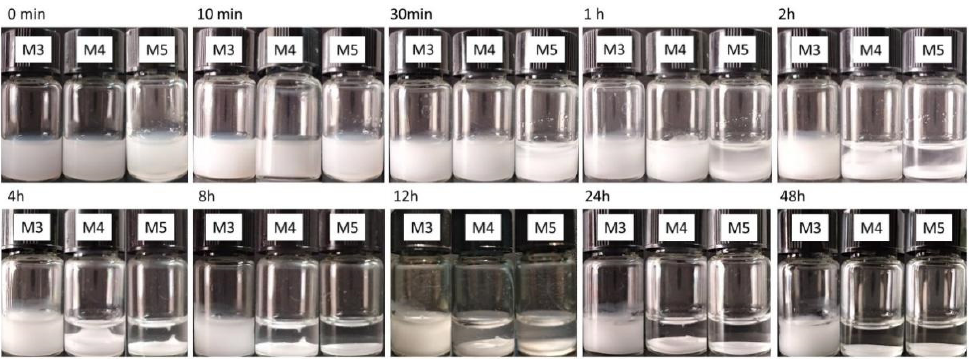
Figure 4. Photographs of the P(OEGMA-co-MEO 2 MA) hydrogels formed from M3 – M5 microgels at different times.